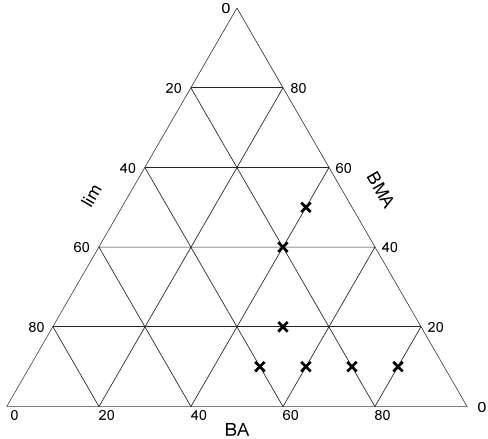
Figure 4. Feed compositions for the n-butyl acrylate (BA)/butyl methacrylate (BMA)/D-limonene (lim) terpolymer, as reported by Ren et al.